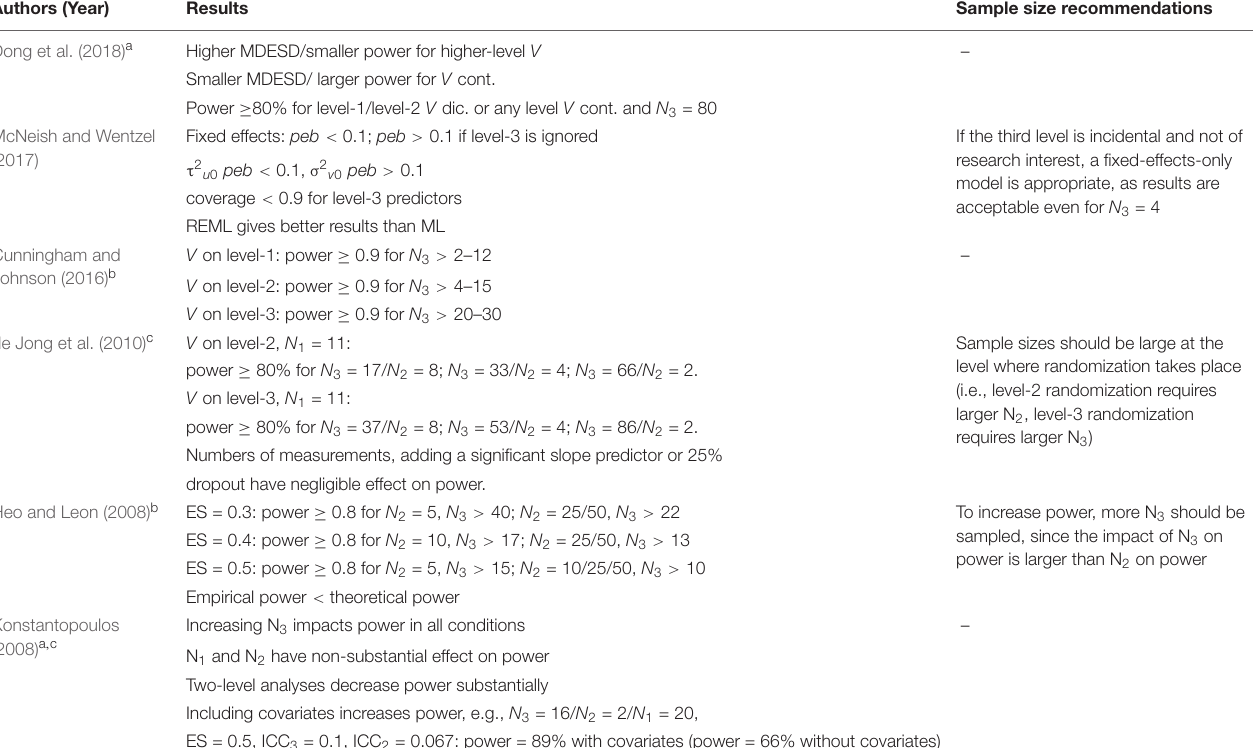
TABLE 4 | Selected results and recommendations of studies examining the impact of sample sizes on estimation results in three-level